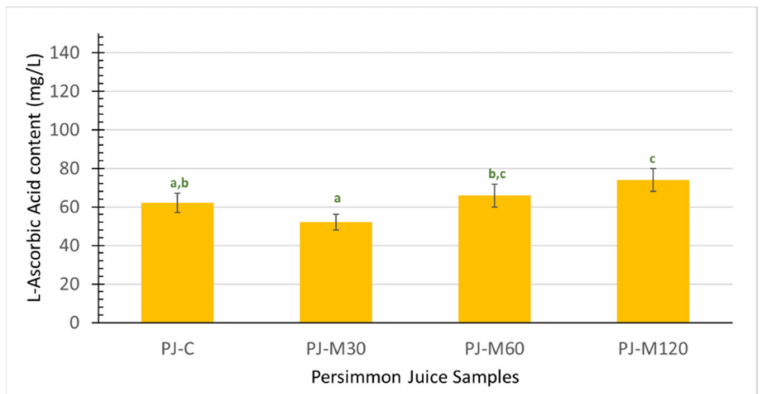
Figure 3. Changes in L-ascorbic acid content (mg/L) of persimmon juice produced without (PJ-C) and after persimmon pulp treatment at different microwave heating conditions (PJ-M30, PJ-M60, PJ-M120). Error bars represent the standard deviation (sd) of the mean value ( n = 4). Different lowercase letters indicate significant differences ( p <